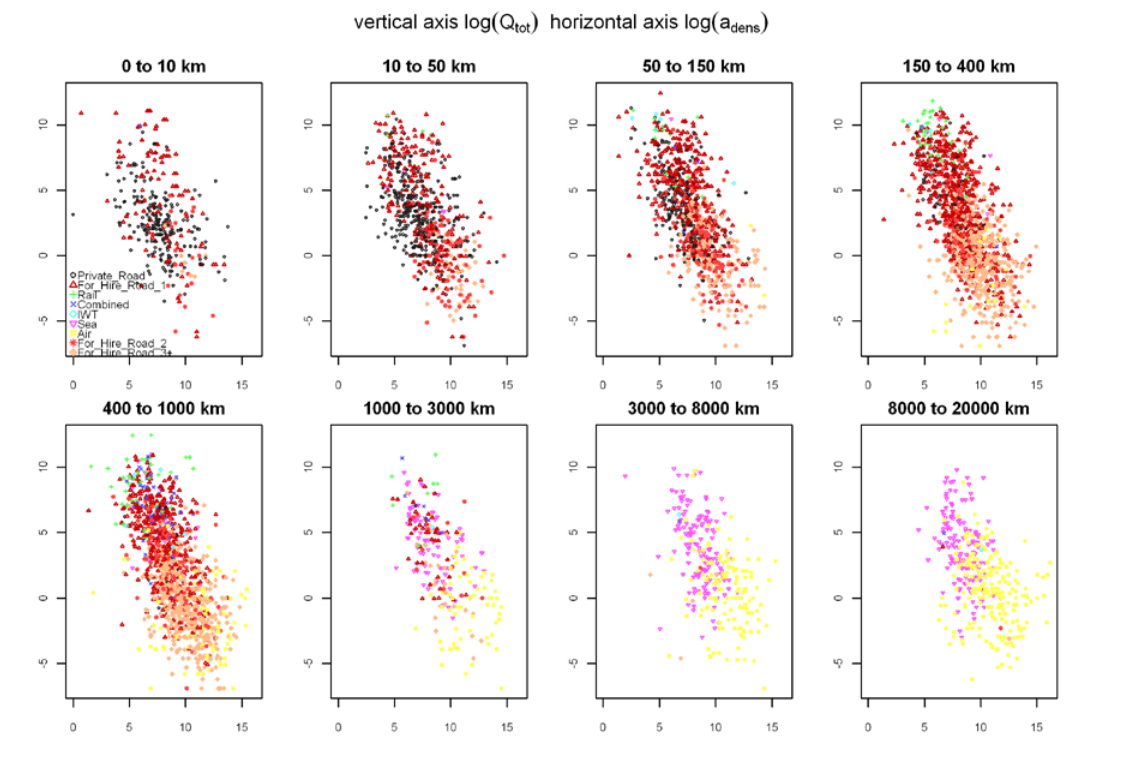
Figure 2. Observed mode choices in the ECHO